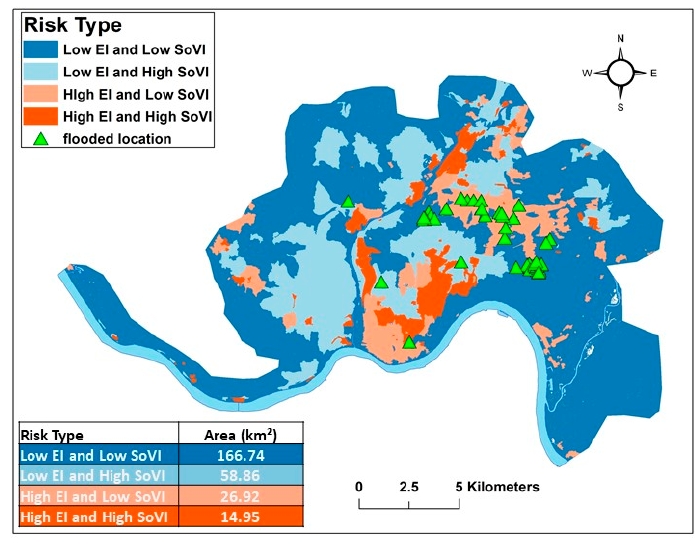
Figure 11. Risk type of urban pluvial flooding.